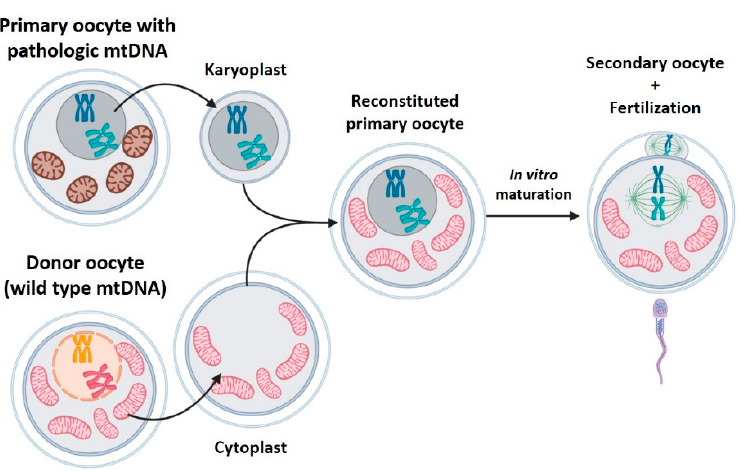
Figure 2. Germinal vesicle transfer (GVT). GVT consists of transplanting the germinal vesicle from a patient’s primary oocyte to a donor oocyte without its germinal vesicle. Created with BioRen- der.com